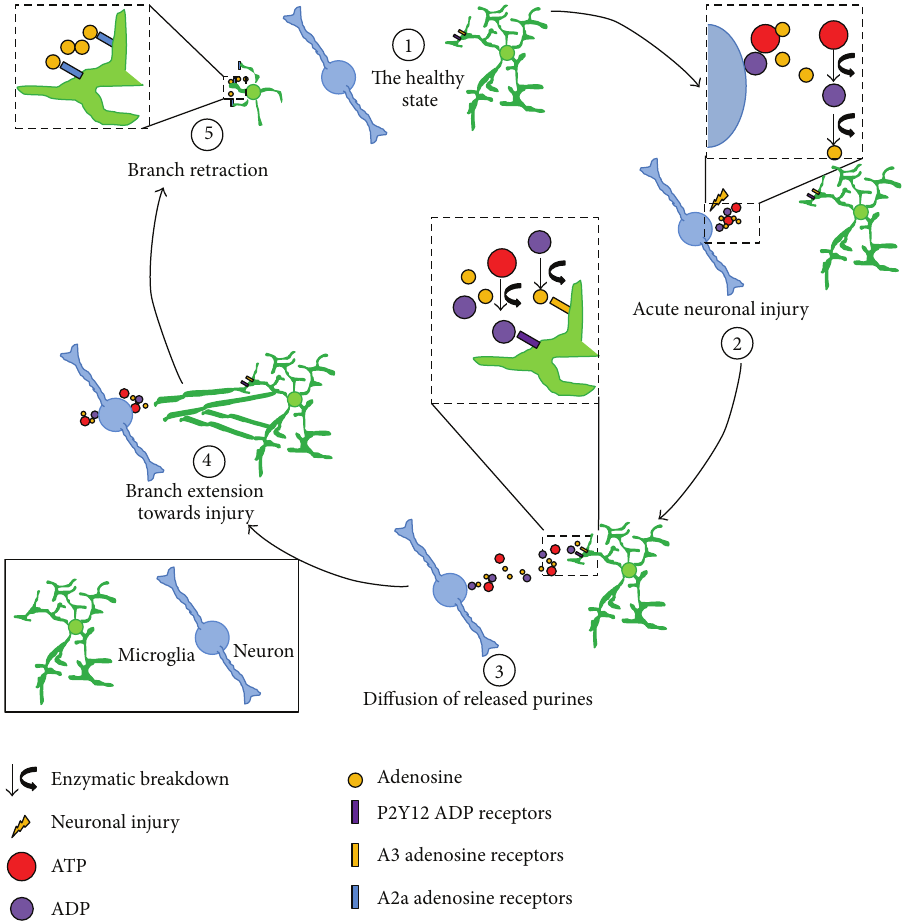
Figure 2: Neuron-to-microglia purinergic signaling regulates microglial extension and retraction. (1) In the healthy brain, microglia exist in close proximity to neurons. (2) In the event of neuronal injury, neurons release purines including ATP which can be degraded by endogenous enzymes into ADP and adenosine (magnification at top right). (3) Released purines diffuse in the extracellular space and can activate P1 (A3) and P2 (P2Y12) receptors on microglia that act in concert (magnification in center). (4) Purinergic activation leads to microglial branch extensiontowardstheinjurysite.(5)Followingmicroglialactivation,adenosinecanalsoactivateA2areceptorsthatmediatemicroglialbranch